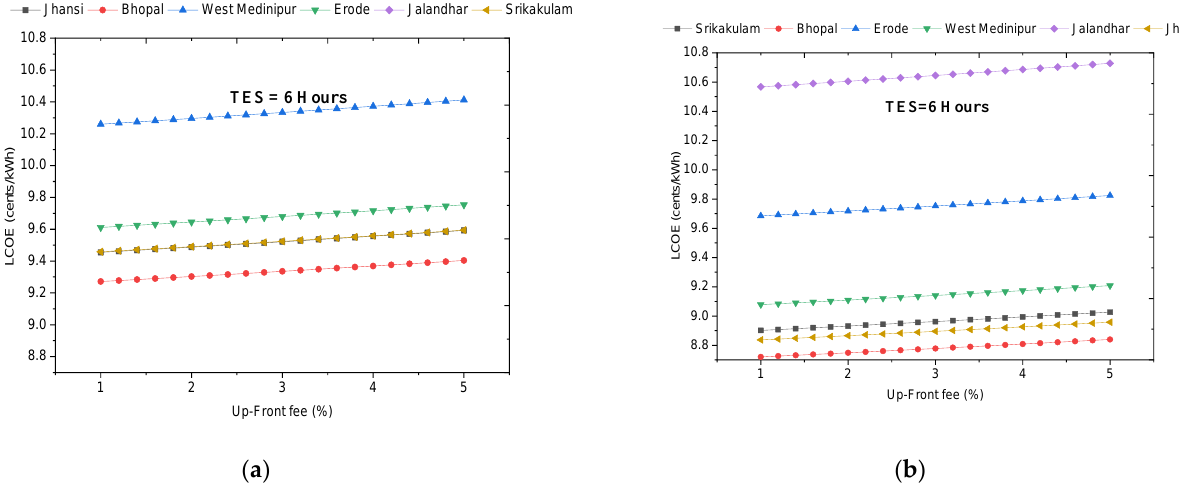
Figure 10. Effect of up-front fee on LCOE of both models, ( a ) dry-cooled and ( b ) wet-cooled, at 6 h TES for SM of 2.